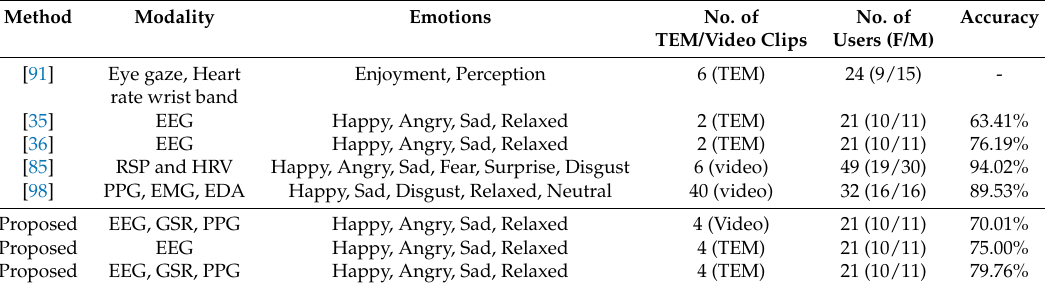
Table 6. Performance comparison of the proposed emotion recognition system in response to TEM with state-of-the-art